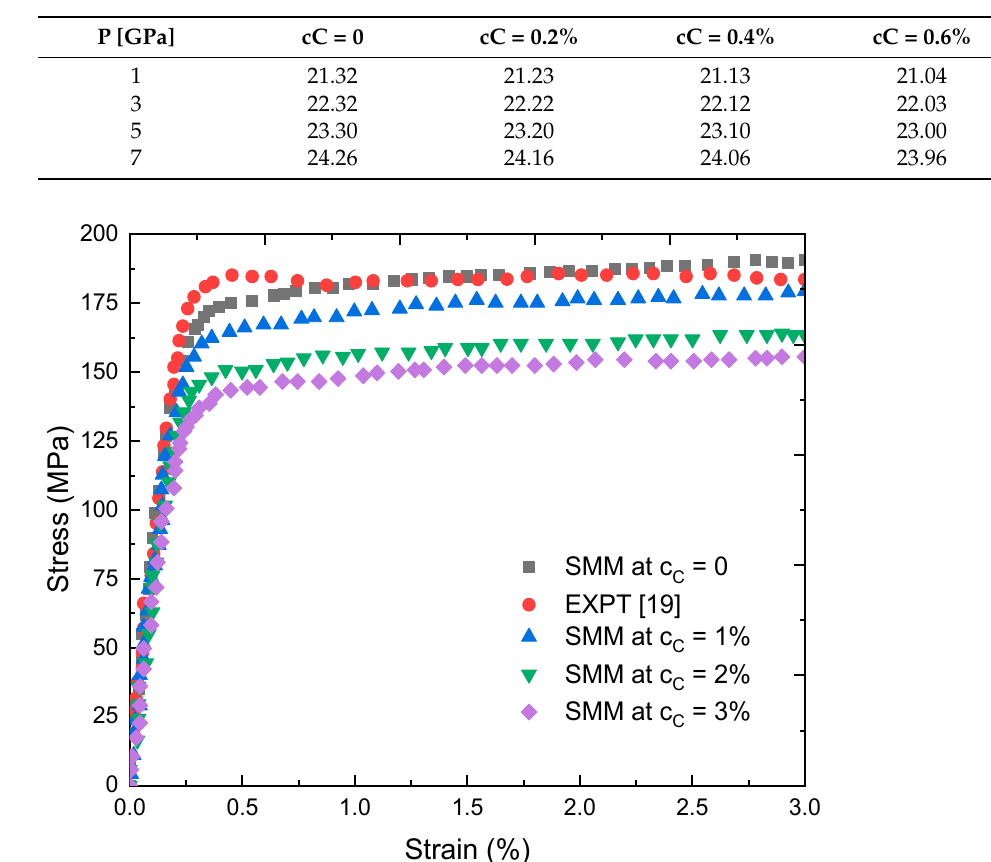
Table 4. E (cC, P) [10 10 Pa] for FeC at T = 300 K determined using the SMM.